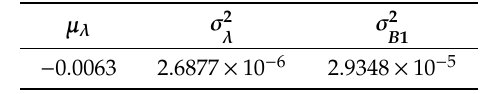
Table 1. The estimation result of the prior parameter Ψ